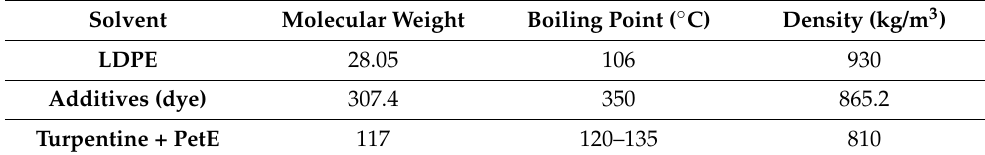
Table 3. Properties of feedstock and mixed solvents.